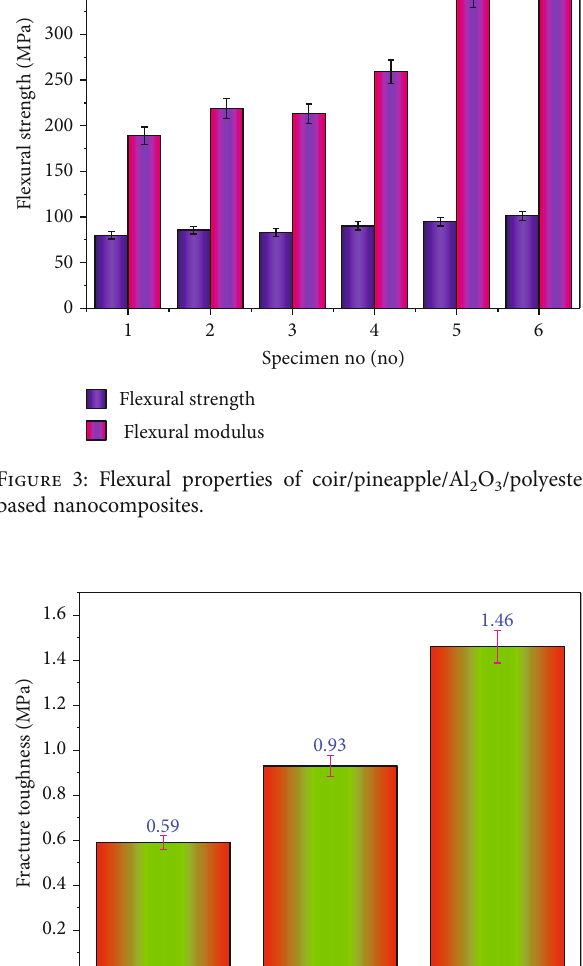
O /polyester- 2 3